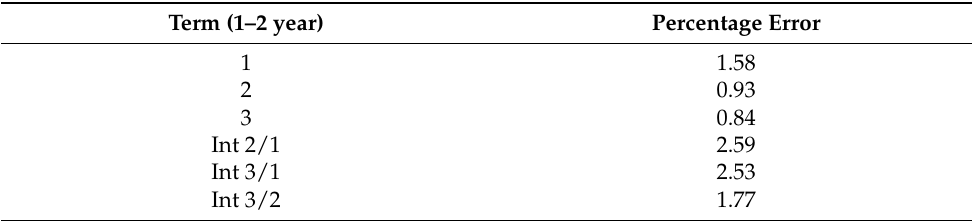
Table 9. Numerical integration errors for post-catXL annual aggregate variance decomposition. Column 1 indicates the various marginal and interaction terms for the 1–2 return period layer. Column 2 has the percentage